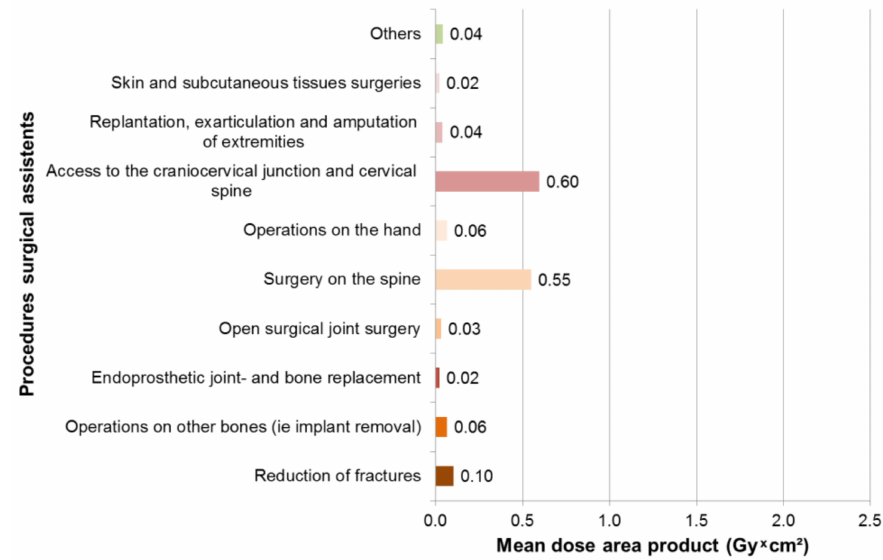
Figure 7. Mean dose area product for surgical assistants, according to procedure type.